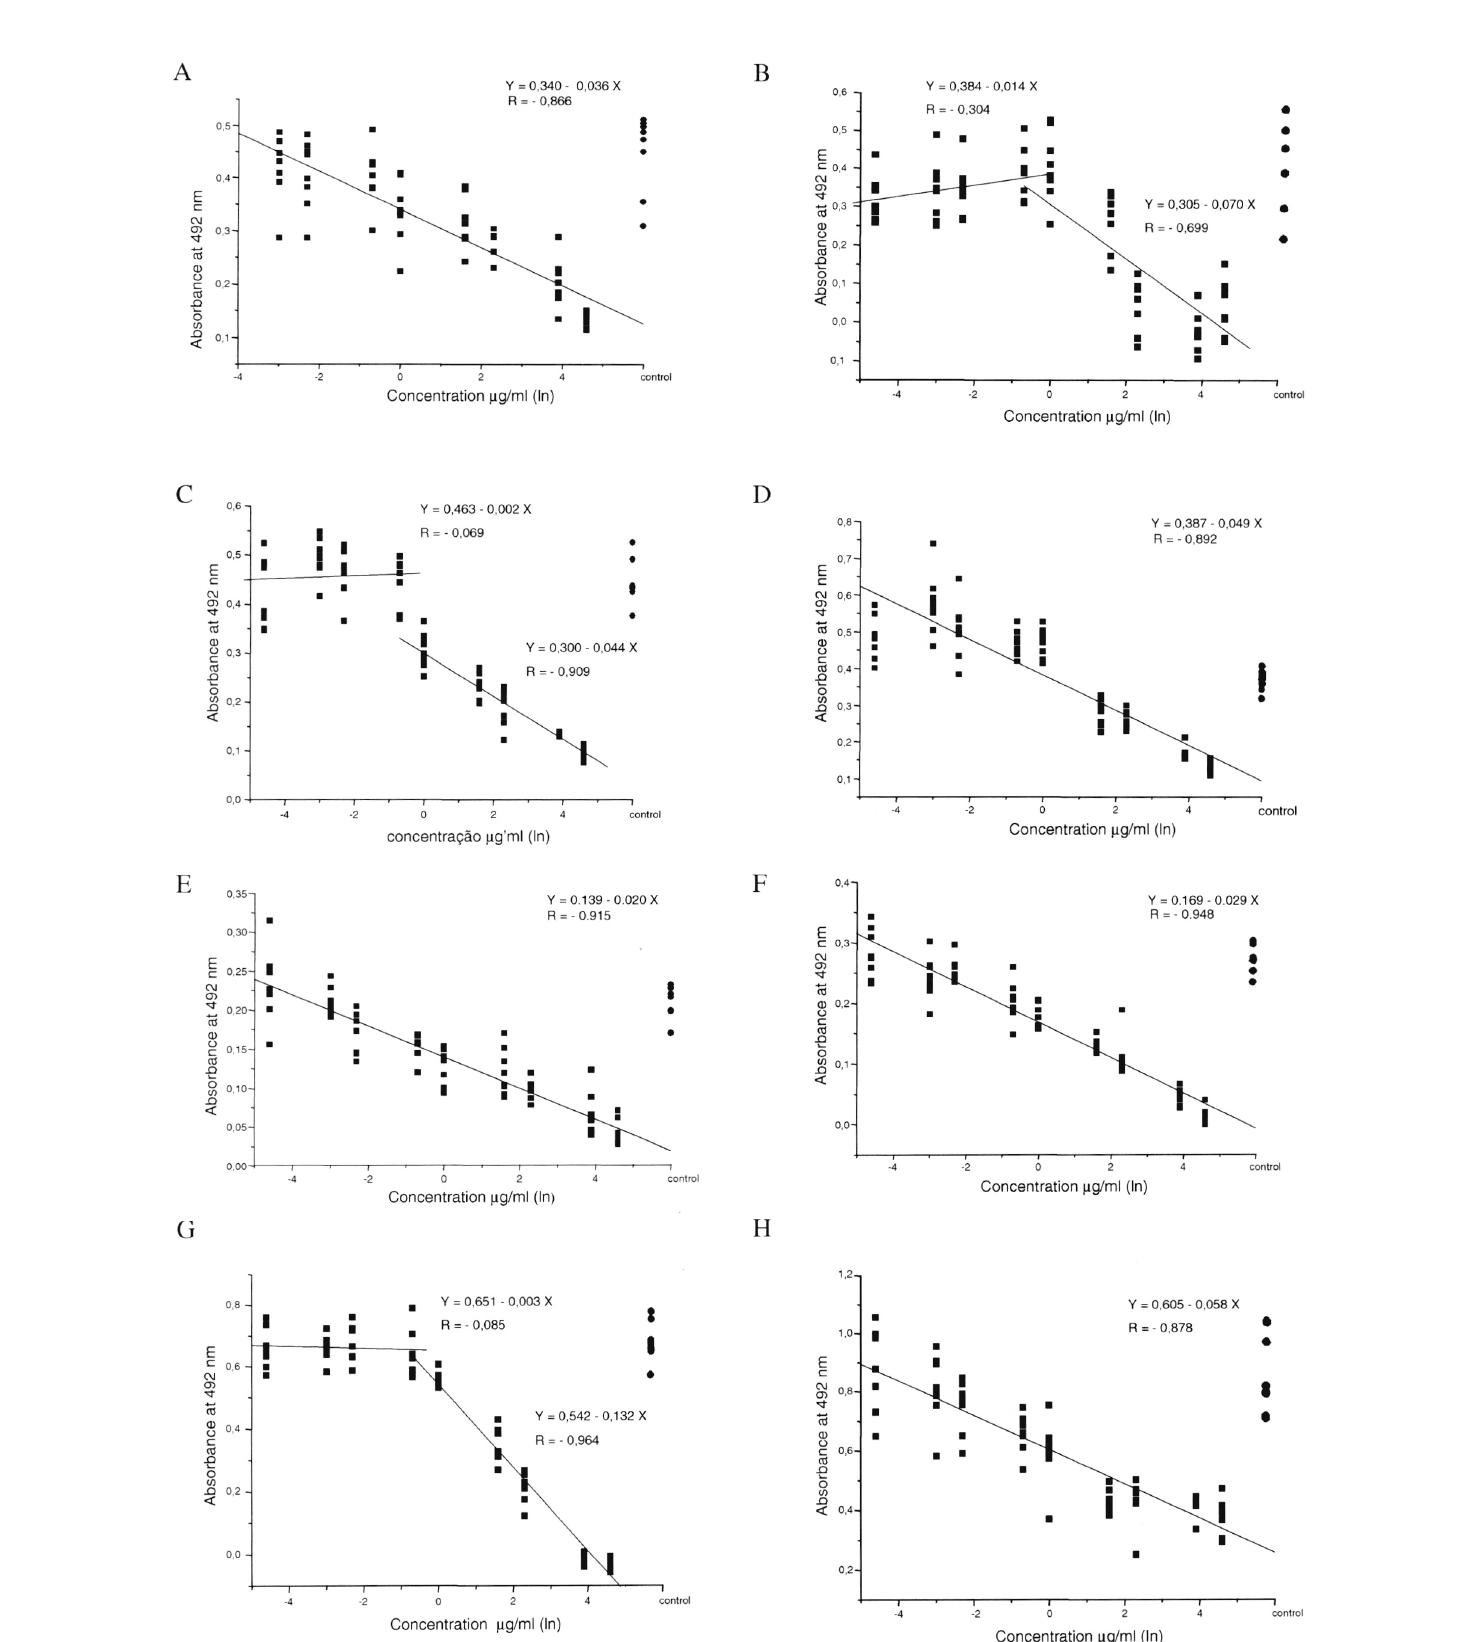
Fig. 2 - In vitro effect of para -hydroxynaphthoquinones PHNQ1 (A), PHNQ2 (B), PHNQ3 (C), PHNQ4 (D), PHNQ5 (E), PHNQ6 (F), PPNQ (G), on Toxoplasma growth. Absorbance values in the enzyme-linked immunosorbent assay of infected cultures were plotted versus the In of the concentrations of drugs. (H) = Reference drug: Sulfadiazine. Control = cultures without drug. Parasite, 2002, 9, 261-269 Mémoire